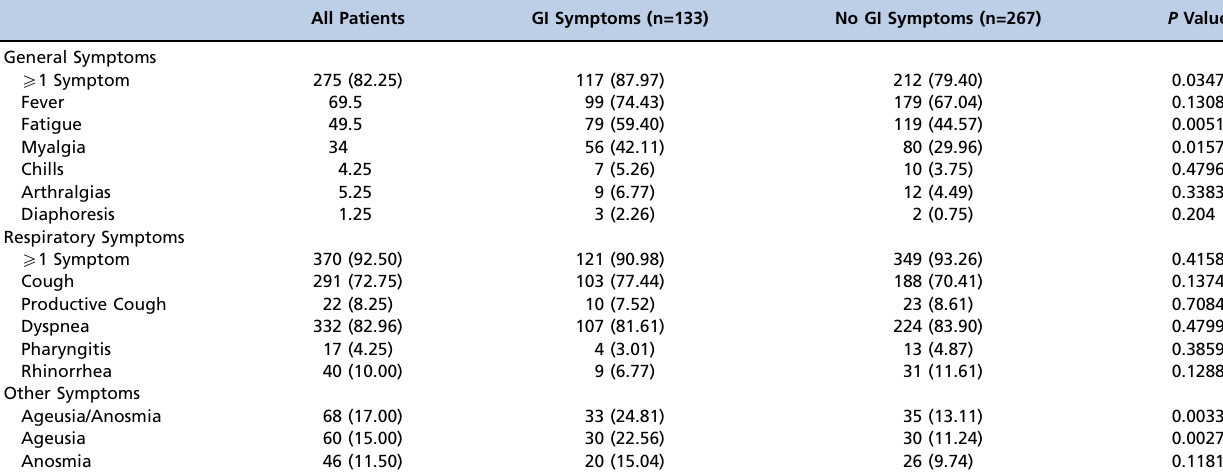
Table 3 - Constitutional, Respiratory, and Other Symptoms at Time of Presentation Among Hospitalized Patients with COVID-19. All Patients GI Symptoms